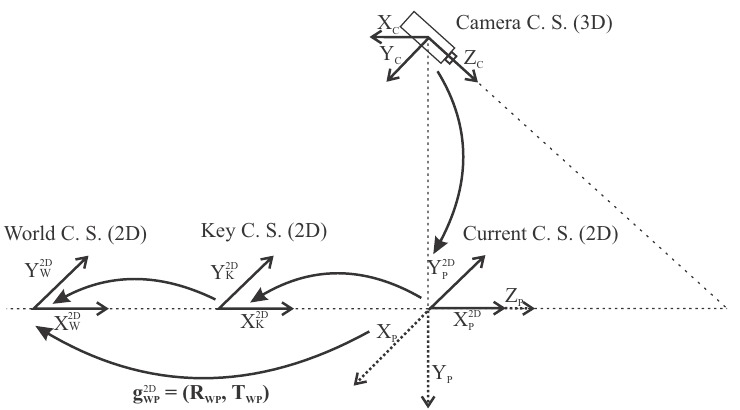
Figure 1. The ARCore tracking algorithm calculates transformation from camera C. S. to world C. S. ARCore’s tracking algorithm computes the 3D transformation from the world C. S. to the camera C. S. (Figure 1). To simplify pose representation, a 3D-to-2D transformation is required. First, to obtain the current 2D pose of a smartphone in the world C. S., the camera C. S. must be transformed to the current C. S. (from 3D to 2D), and second, the transformation g 2 D from the current C. S. to the world C. S. must be WP